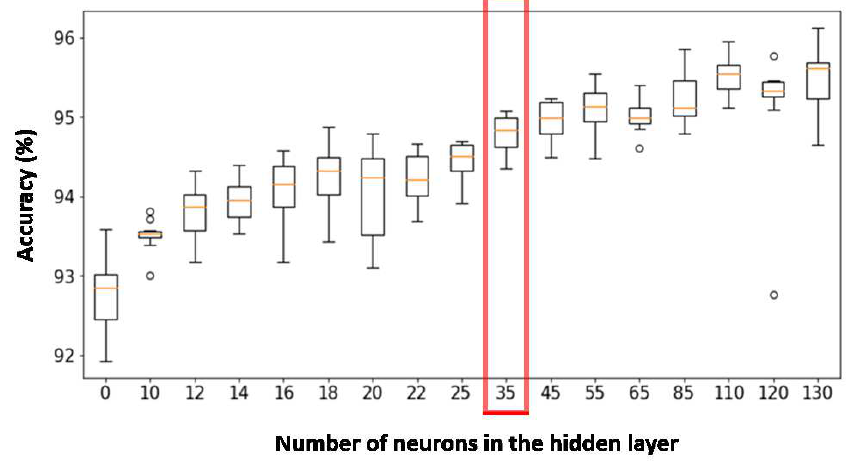
Figure 8. Accuracy obtained for every activity classifier architecture with 10 cross